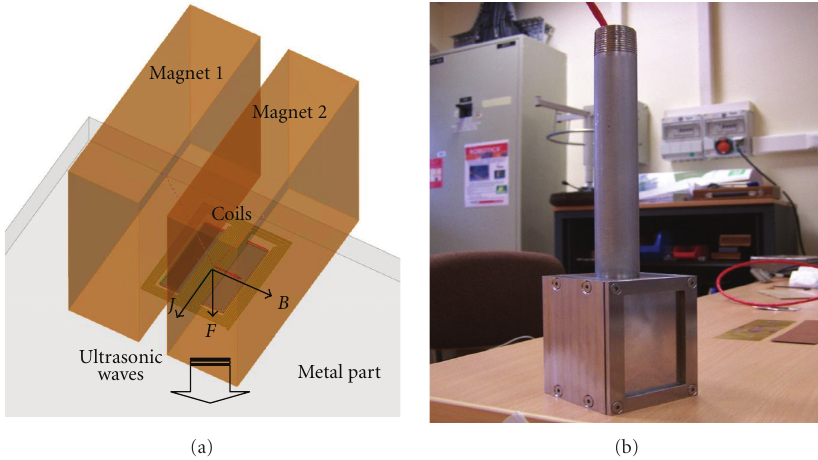
Figure 15: Available undersodium transducers.